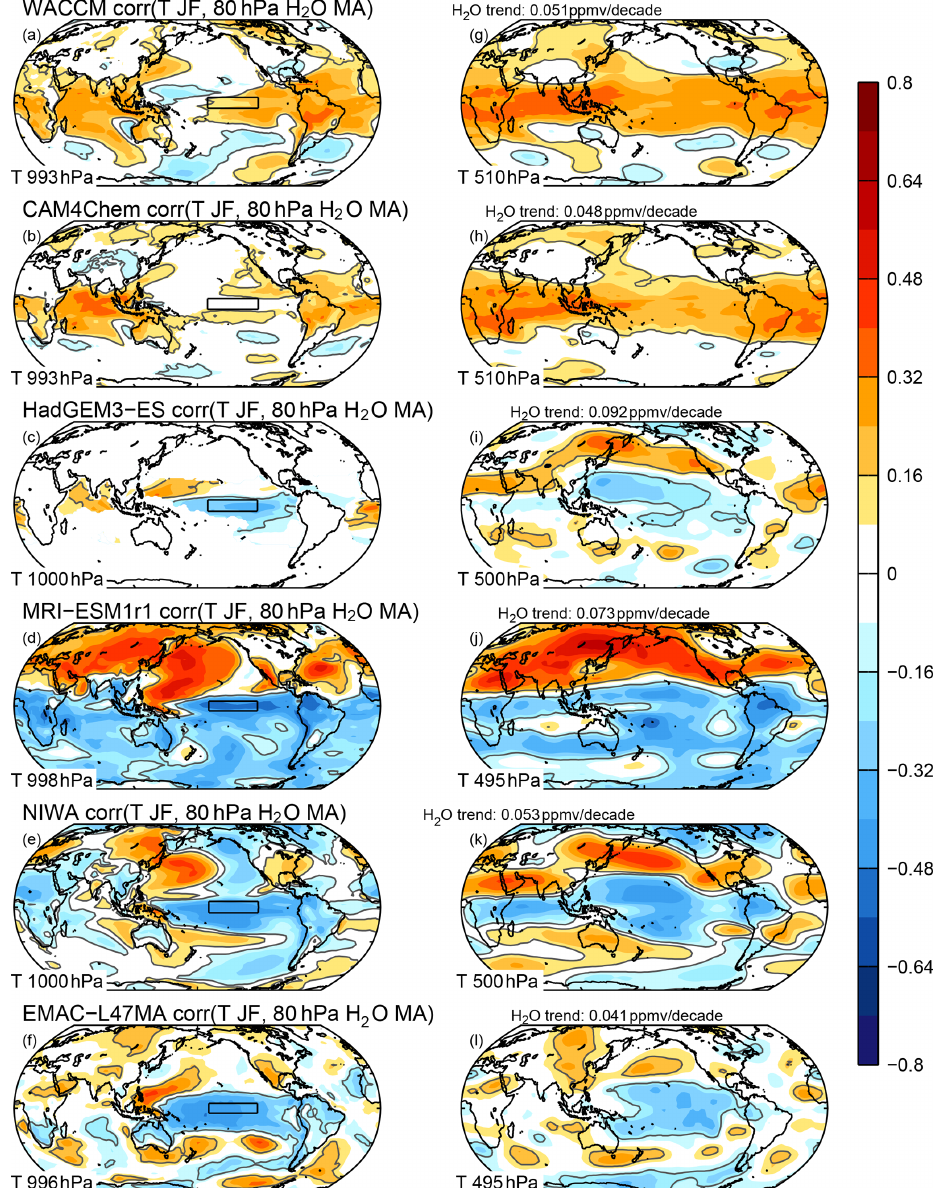
Figure 4. Correlation of (left) near-surface temperature and (right) temperature near 500hPa with entry water vapor in each of the CCMI models, with temperature taken for January and February and water vapor for March and April. A black line indicates correlations signifi- cantly different from zero at the 95% confidence